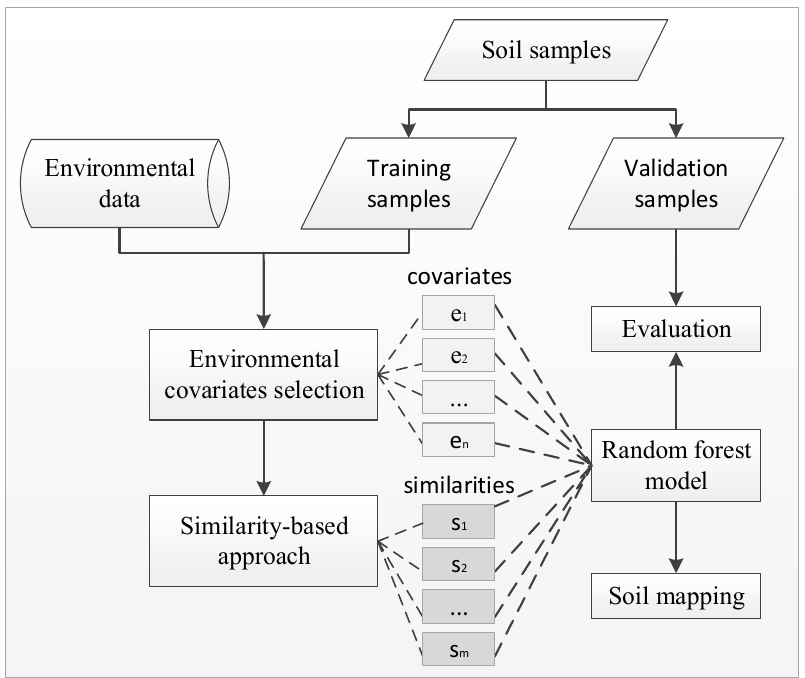
Figure 3. Flowchart of the integrated method.